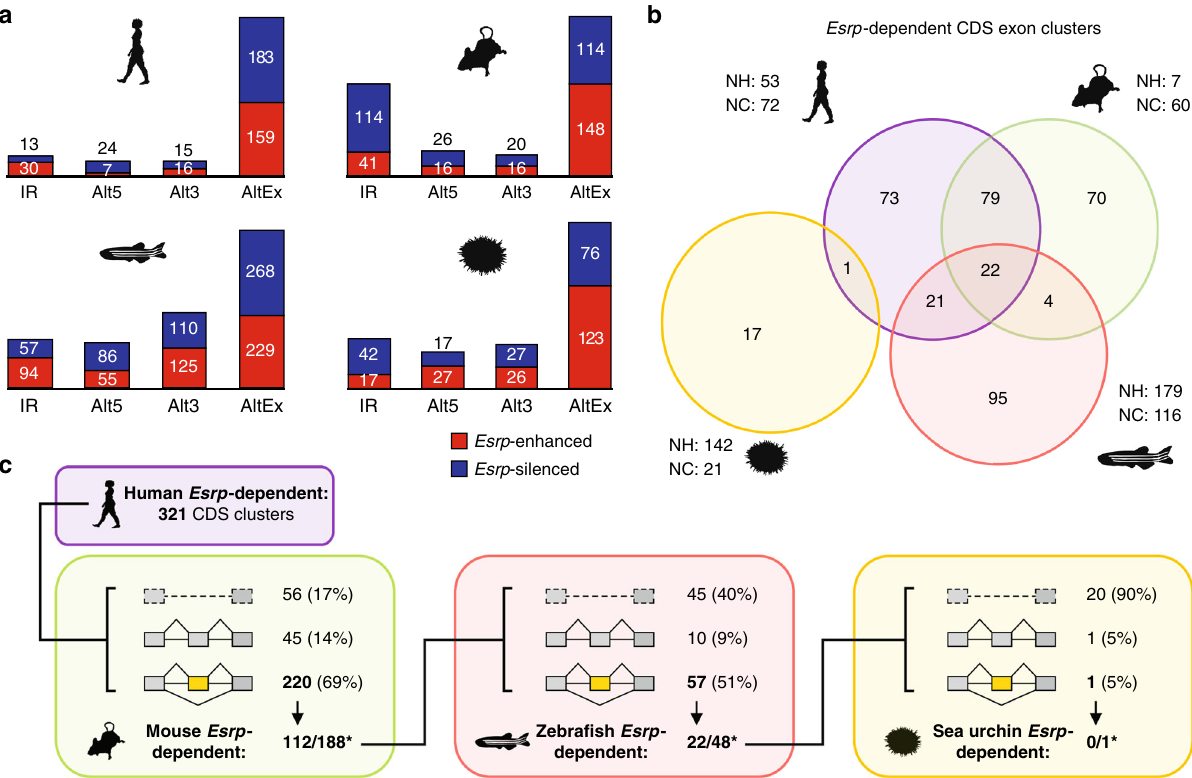
Fig. 5 Evolution of Esrp -dependent splicing programs. a Number Esrp -dependent AS events by type detected in human, mouse, zebra fi sh and sea urchin, RNA- seq samples. Red/blue bars correspond to Esrp -enhanced/silenced inclusion of the alternative sequence. IR, intron retention; Alt5, alternative 5 ′ splice site choice; Alt3, alternative 3 ′ splice site choice; AltEx, alternative cassette exons. b Venn diagram showing the overlap among homologous Esrp -dependent cassette exons in coding regions detected as regulated in the same direction in the studied species. Only Esrp -dependent exons with homologs in at least two species and suf fi cient read coverage in all the species in which they have homologs are included in the comparison. Esrp -dependent exons that lack homologous counterparts in all the other species are indicated for each species (NH). Similarly, the number of Esrp -dependent exons that do not have suf fi cient read coverage in at least one of the species with a homologous exon is displayed for each species (NC). c Summary of conservation at the level of genomic presence, alternative splicing and Esrp -dependency for all 321 clusters of human Esrp -dependent coding exons in other species. Shared Esrp -dependent exons between the previous phylogenetic group are classi fi ed in the test species into three categories: (i) the exon is not detected in the genome (top row, discontinuous line); (ii) the homologous exon is detected in the genome, but it is constitutively spliced (middle row, gray exon); and (iii) the homologous exon is alternatively spliced (bottom row, yellow exon, numbers in bold). Below this classi fi cation, the number of similarly regulated Esrp -dependent exons shared by the two species/ lineages over the number of alternatively spliced exons with suf fi cient read coverage from (iii) (indicated by asterisks), is